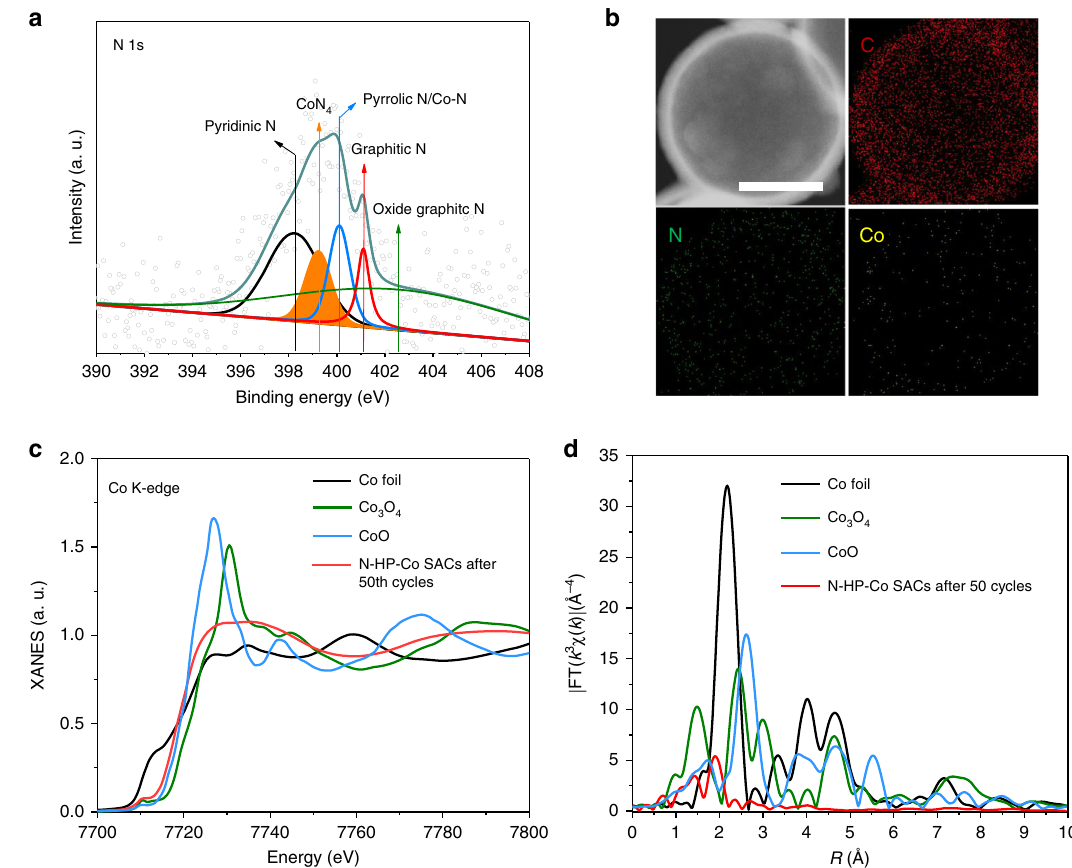
Fig. 7 Cycling stability of N-HP-Co SACs. a N 1 s XPS spectra for N-HP-Co SACs after 50 galvanostatic cycles. b HAADF-STEM images and the corresponding EDX elemental maps after 50 galvanostatic cycles, 200 nm in b . c , d XANES spectra and Fourier transform of the Co K-edge of N-HP-Co SACs, Co 3 O 4 , CoO, and Co